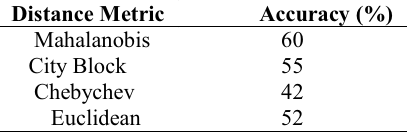
Table 5. Distance Metric using convex hull